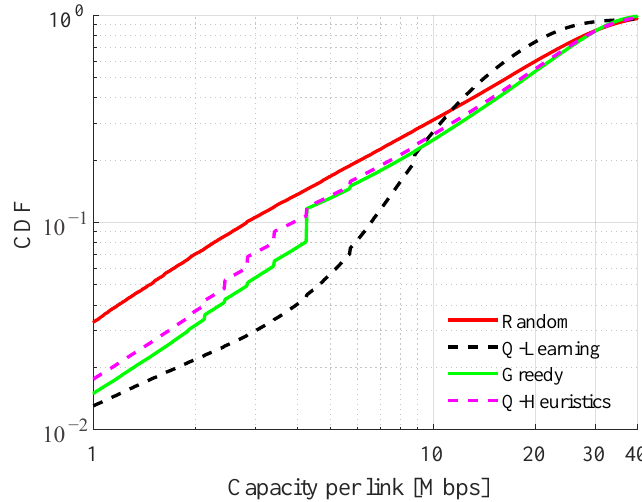
Figure 6. CDF of capacity per inXS with s th = 2